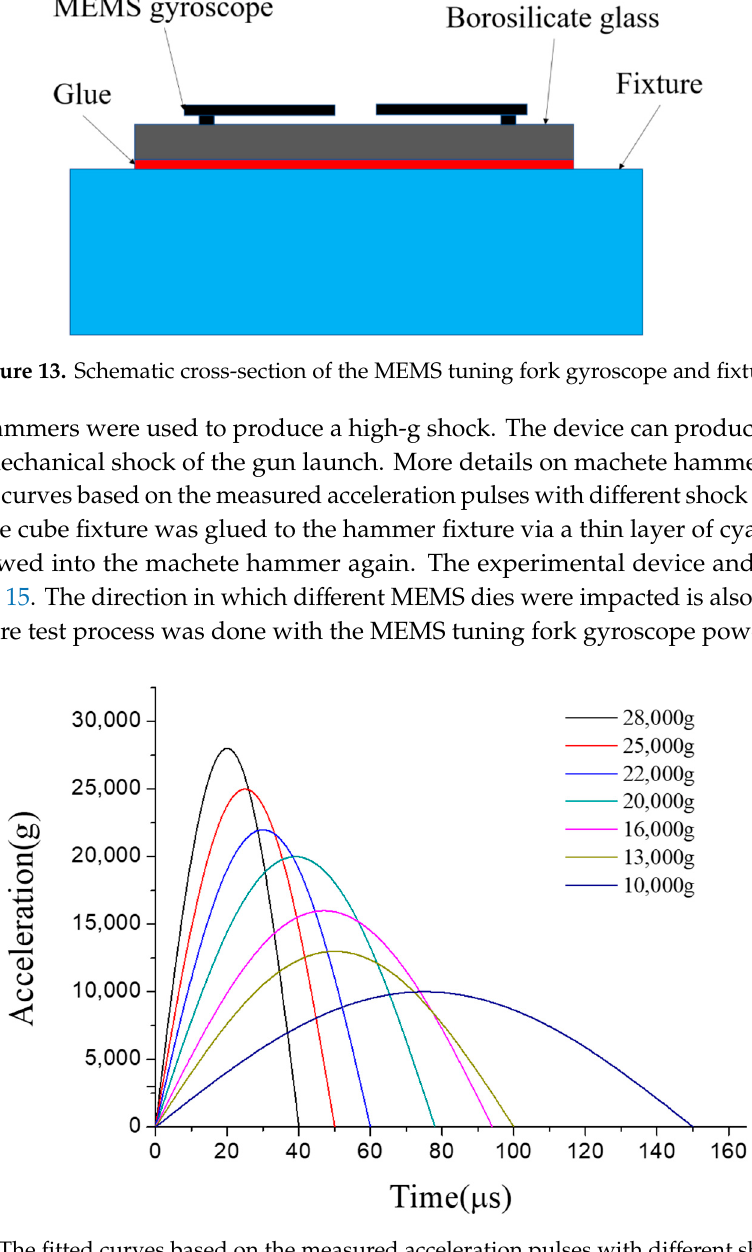
Figure 15. The experimental device and installation. In order to avoid cumulative damage [19,20], pre-tests were operated to determine the range of critical acceleration for the failure of MEMS tuning fork gyroscope. Then, new MEMS dies were used for the impact . The MEMS dies were glued to the surfaces of the cube fixture. Then, when the device was operated, the MEMS dies were impacted along the X/Y/Z axes simultaneously. The location of failure on the damaged sample was observed with a microscope after impact. In order to be able to view the structure of the gyroscope directly with a microscope after the impact, and to avoid secondary damage to the structure of the gyroscope when the package is disassembled, the experiment was carried out in the air. This will inevitably add the effect of air damping on the experiment. The studies [13,17–18] show that air damping will reduce critical acceleration, but the law of the acceleration curve is consistent with the curve of the test result in